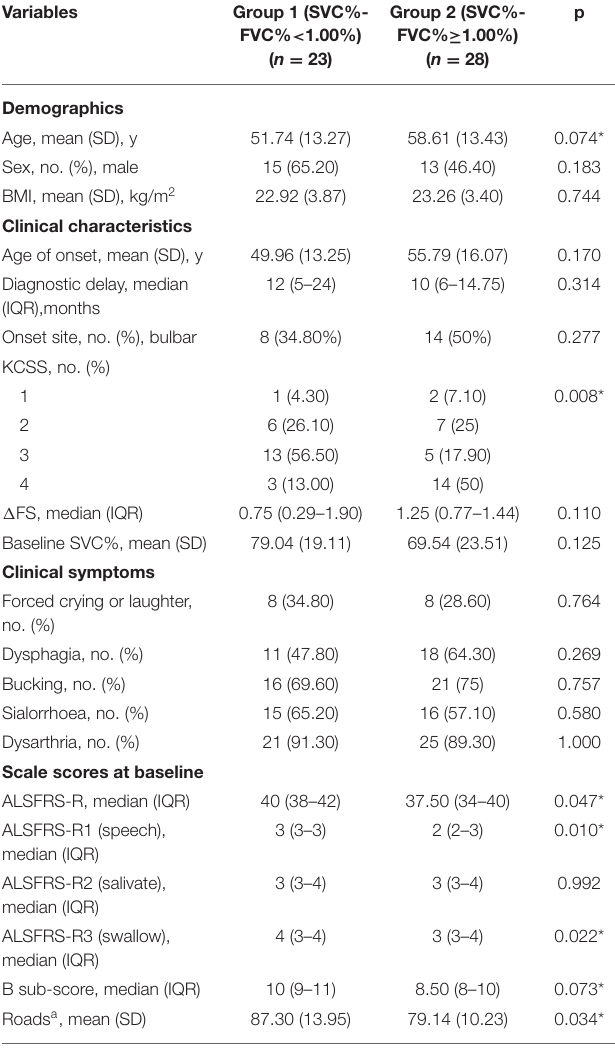
TABLE 2 | The difference of demographics, clinical characteristics and scale scores at baseline between 2 groups which were divided by median SVC%-FVC%.